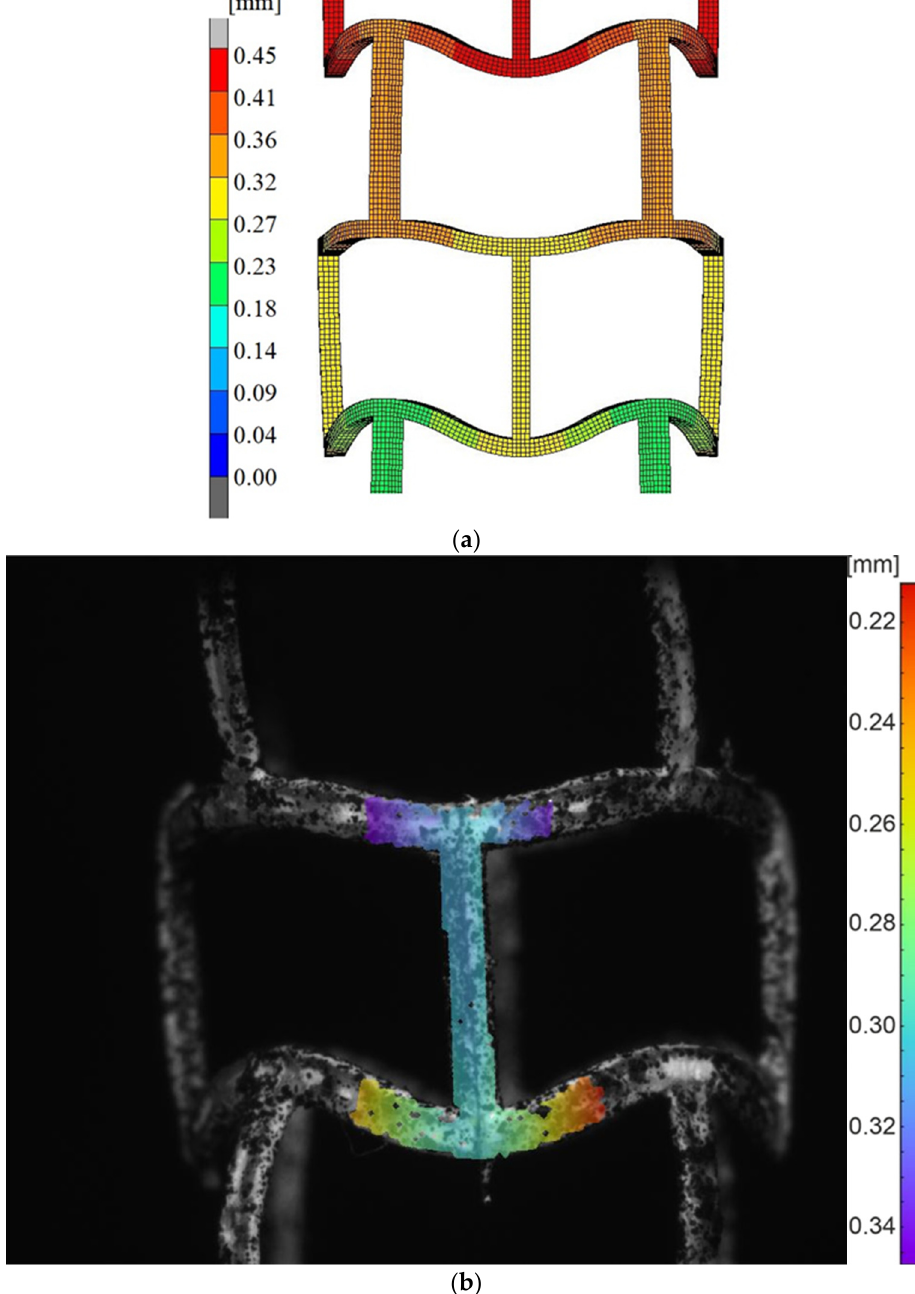
Figure 19 . Displacement maps for longitudinal compression: ( a ) simulated using FEM, ( b ) measured using DIC .